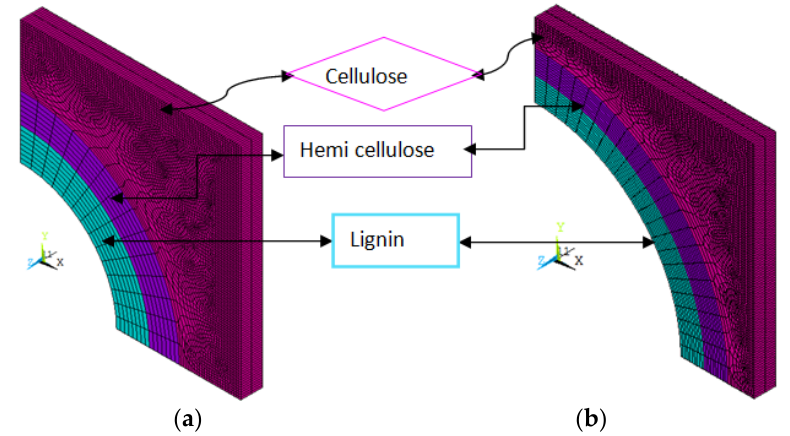
Figure 5. Finite Element Model of H1 ( a ) and H6 ( b ) models.